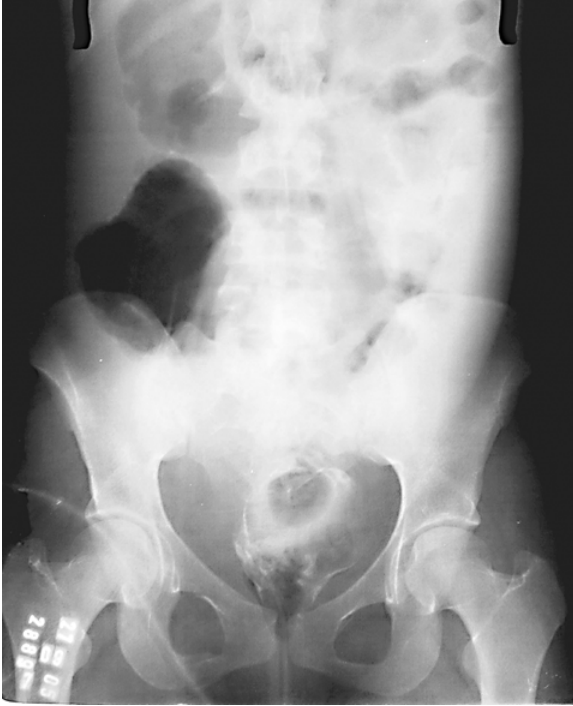
Figure 3 – Cystography showing intraperitoneal bladder